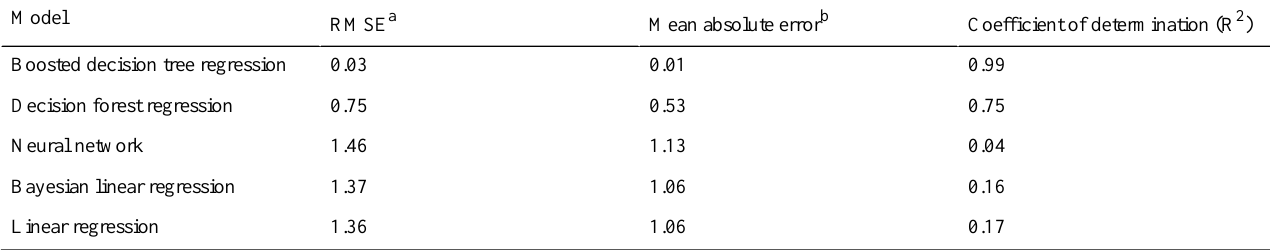
Table 3. Comparison of modeling techniques ranked from best to worst based on root mean squared error